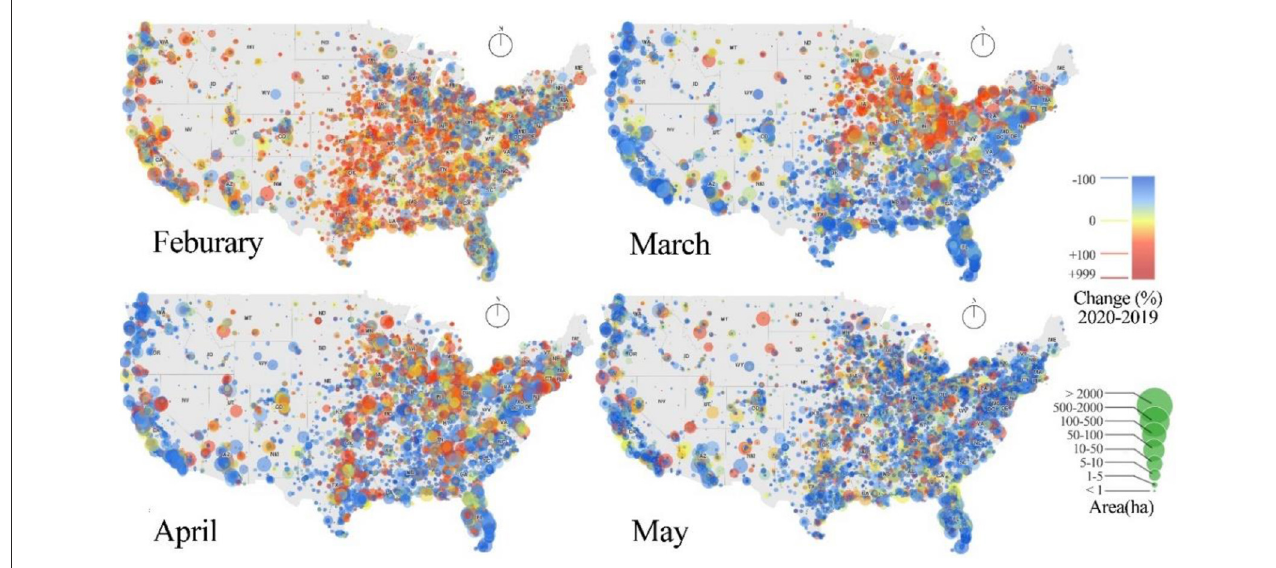
FIGURE1 The change in the number of public park visitors between 2019 and 2020.